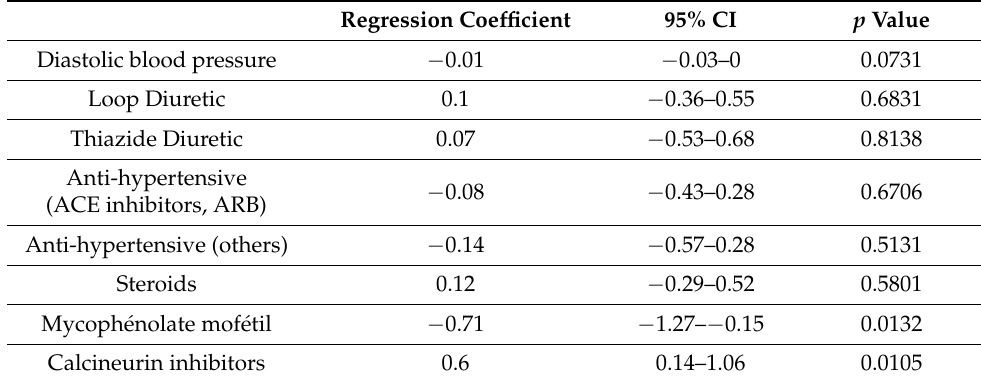
Figure 3. Kaplan Meier curve of composite outcome of death, graft loss or rapid decline of renal function by sodium level. Hyponatremia was neither associated with graft loss nor with death (HR 1.13, p = 0.68, 95%CI: 0.63 – 2.04) (Figure 4).